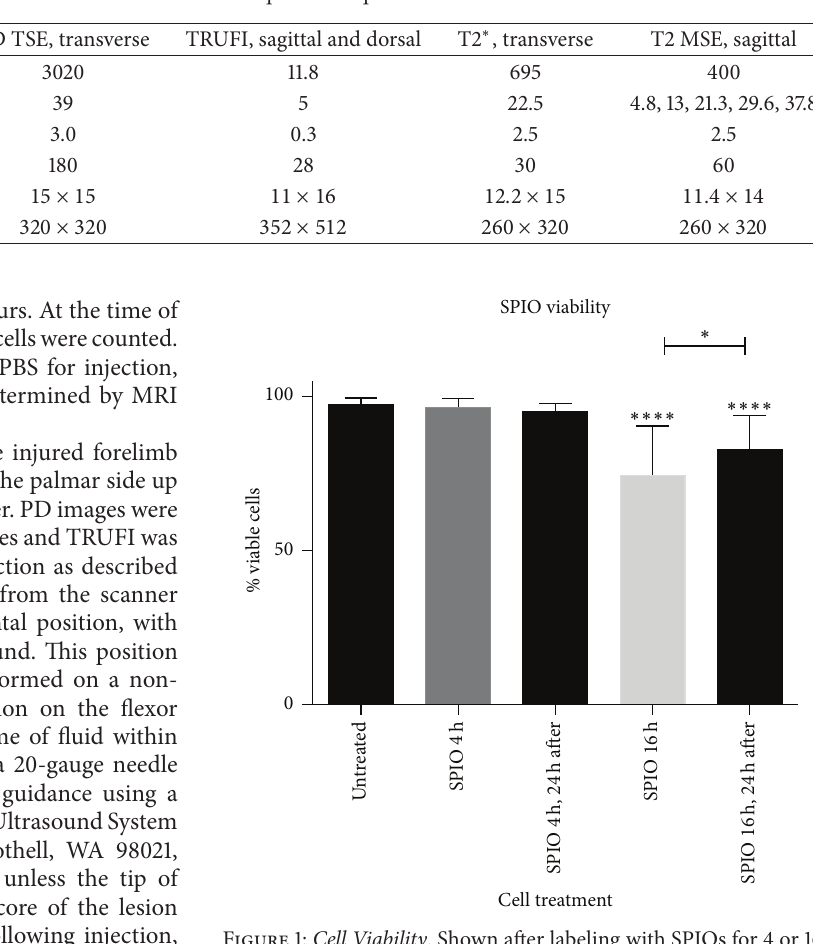
Table 1: Parameters for MRI sequences acquired.